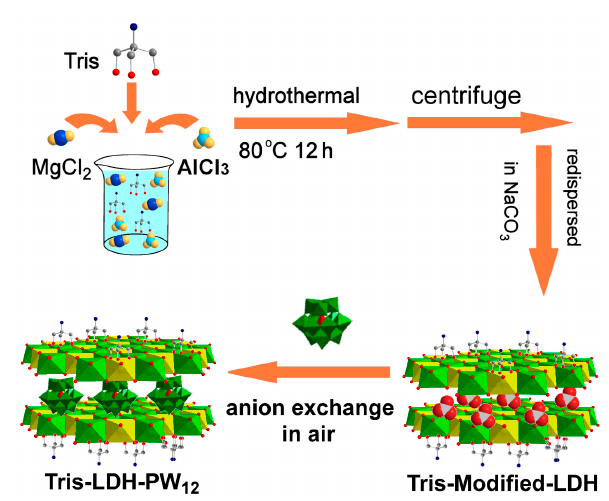
Figure 4. Schematic representation of the host layer modification method to prepare POM ‐ LDH composite (Tris ‐ LDH ‐ PW 12 ). Adapted from Ref. [41], Copyright 2014, Royal Society of Chemistry.